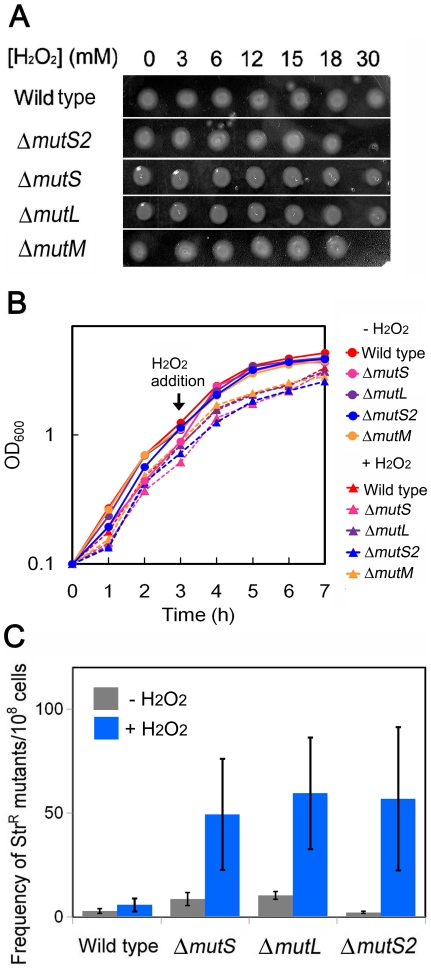
Effect of gene disruption on the tolerance to H2O2 and the rate of H2O2-induced mutagenesis.(A) Sensitivity to H2O2. The wild-type, ΔmutS2, ΔmutS, ΔmutL, and ΔmutM strains of T. thermophilus HB8 were incubated in medium containing the indicated concentrations of H2O2. After incubation with H2O2, cells were spotted onto plates. (B) Effect of 10 mM H2O2 on growth curves of the wild-type (red), ΔmutS (pink), ΔmutL (purple), ΔmutS2 (blue), and ΔmutM (orange) strains of T. thermophilus HB8. Precultured cells were inoculated to 5 ml of medium to an OD600 value of 0.10. After incubation at 70°C for 3 h, 50 µl of 0 (circles) or 1 M (triangles) H2O2 was added. (C) Rate of H2O2-induced mutagenesis. The wild-type, ΔmutS, ΔmutL, and ΔmutS2 strains of T. thermophilus HB8 were incubated in medium containing 0 or 10 mM H2O2 for 30 min. After incubation, cells were spread onto plates containing 0 or 50 µg/ml streptomycin. Frequency of streptomycin-resistant mutants per 108 cells was calculated from the numbers of colonies formed on the streptomycin-containing and drug-free plates. Bars indicate standard deviations.